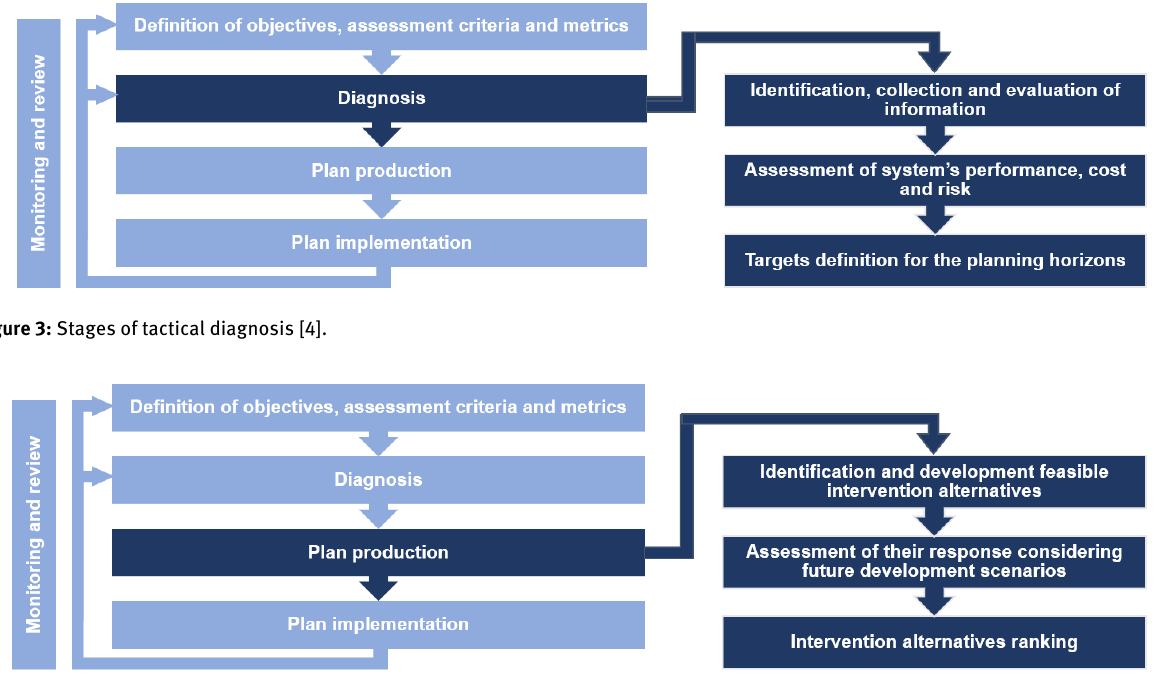
Figure 4: Stages of plan production